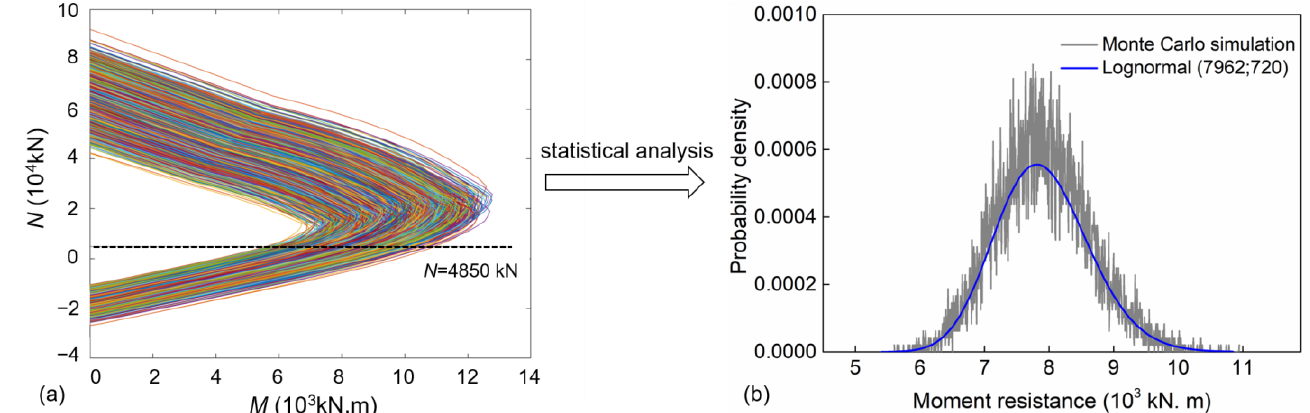
Figure 2. Moment resistance distribution of a pier, based on an M–N interaction diagram. ( a ) cal- culated M-N interaction diagrams ( b ) Probability distribution of moment resistance.